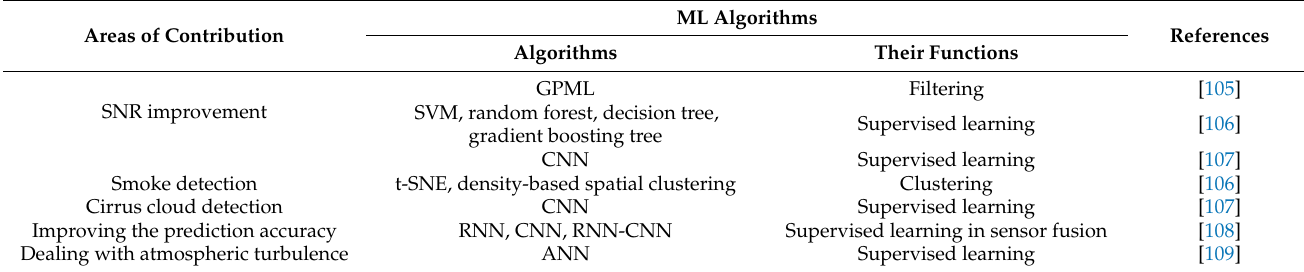
Table 14. Overview of the contributions of ML algorithms to atmospheric beam propagation. Areas of